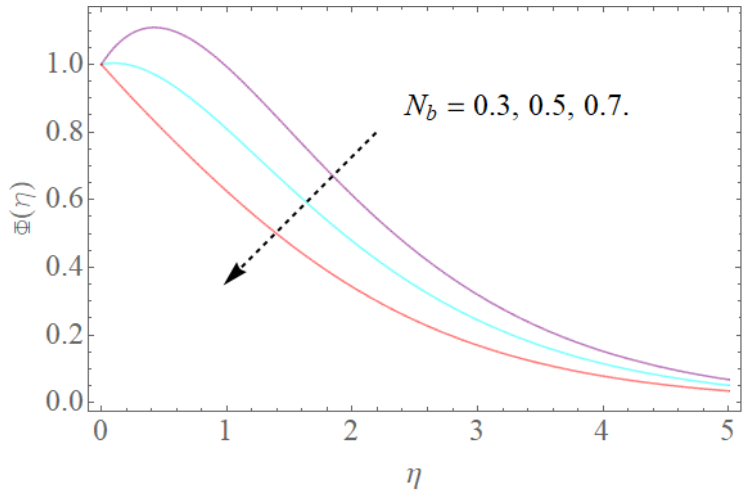
Φ ( η ) when N t = 0.3, Sc = 1.0.